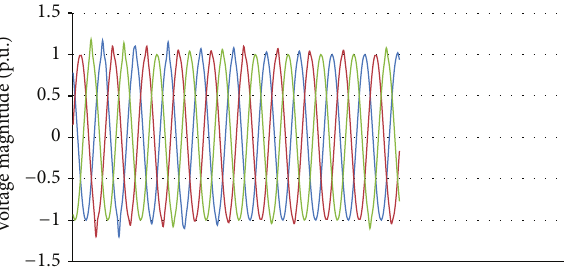
Figure 21: Waveform of simulated voltage swell.